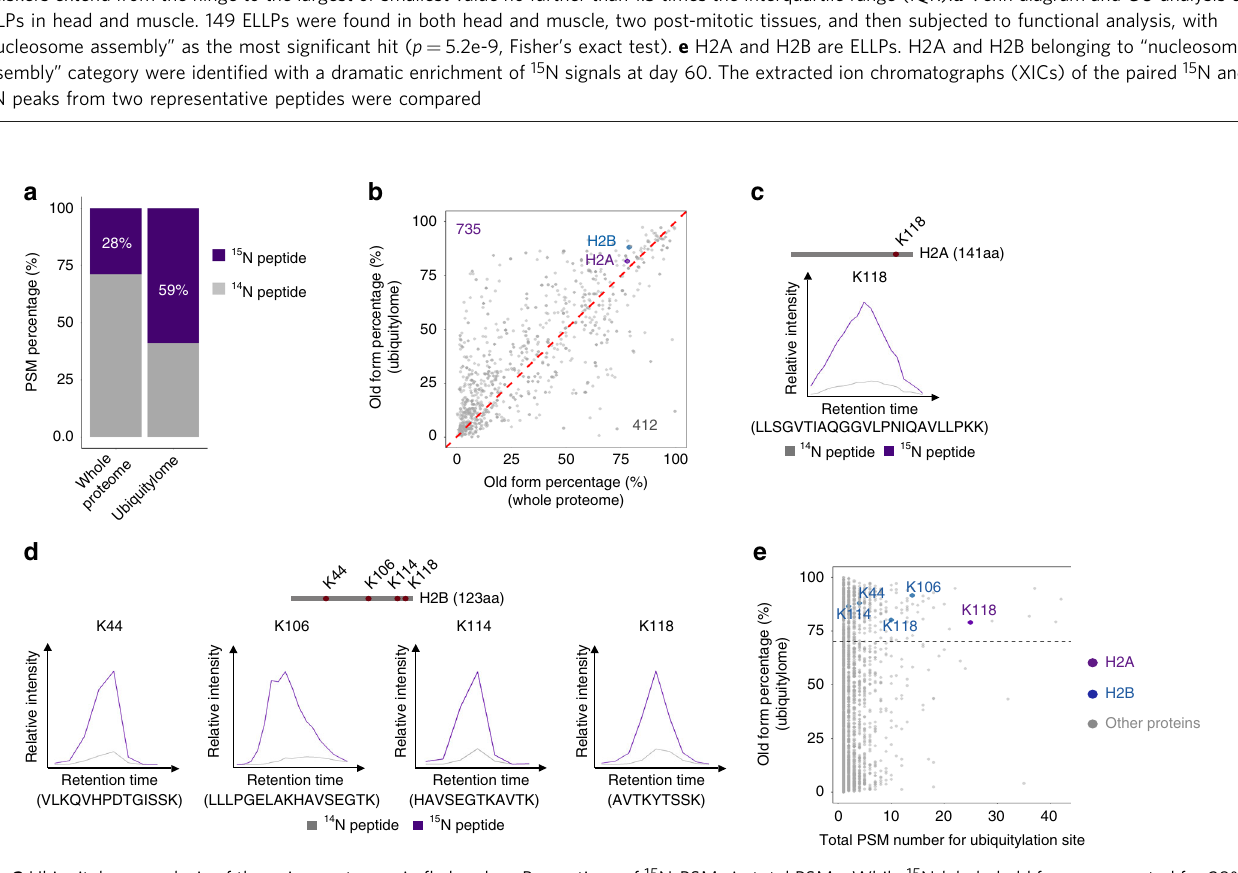
Fig. 2 Ubiquitylome analysis of the aging proteome in fl y heads. a Proportions of 15 N-PSMs in total PSMs. While 15 N-labeled old forms accounted for 28% of the entire proteome at 60d, they represented 59% of the ubiquitylated proteome, suggesting increased ubiquitylation in older proteome. b Quanti fi cations of 15 N signals in total proteins and ubiquitylated proteins. A scatter plot of 15 N ratio con fi rms a majority of the proteins have higher 15 N proportion in ubiquitylome than that of the normal aging proteome at 60d of age ( p = 2.2e-16, Mann – Whitney-Wilcoxon test). c , d Ubiquitylated histone proteins are featured by higher 15 N ratios, including H2A ( c ) and H2B ( d ). The XICs of the paired 15 N and 14 N peaks were compared. e Quanti fi cation of 15 N proportions and abundance of ubiquitylated sites. H2A has high-abundance in the level of ubiquitylation, as assessed by the PSM